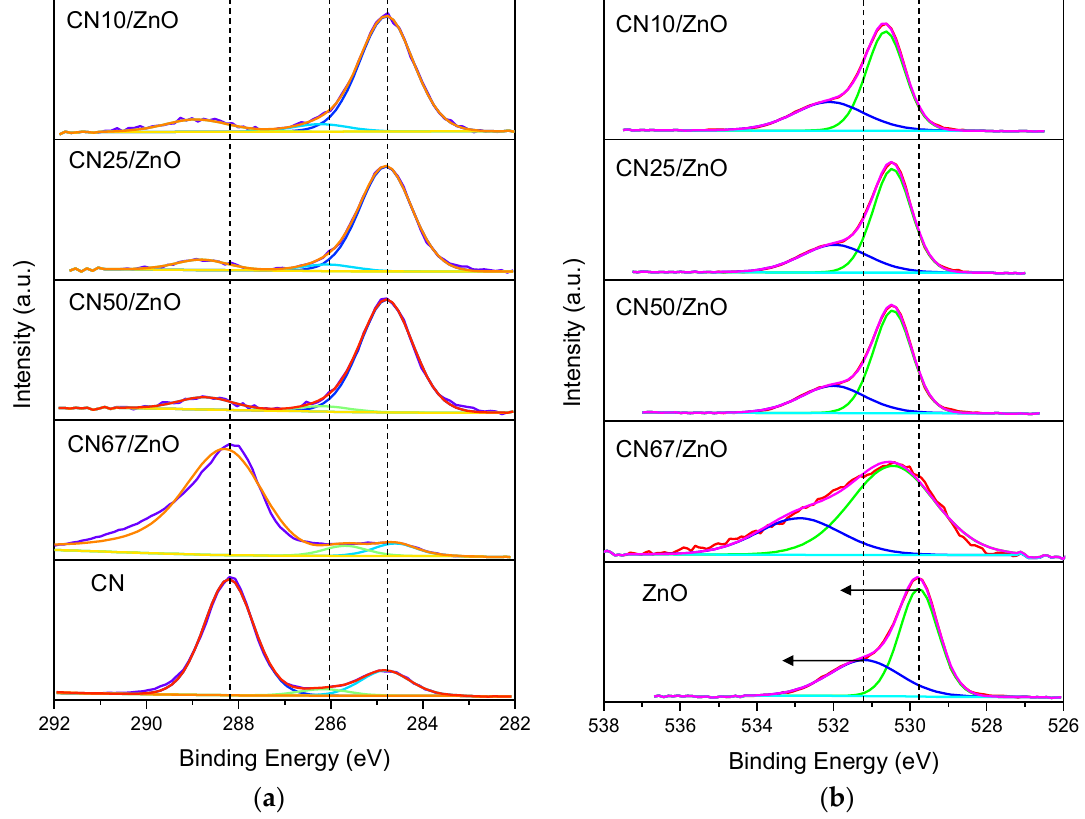
Figure 4. XPS spectra and deconvolution of ( a ) C1s and ( b ) O1s regions of CN/ZnO composites. Pure CN and pristine ZnO are also plotted for comparison.